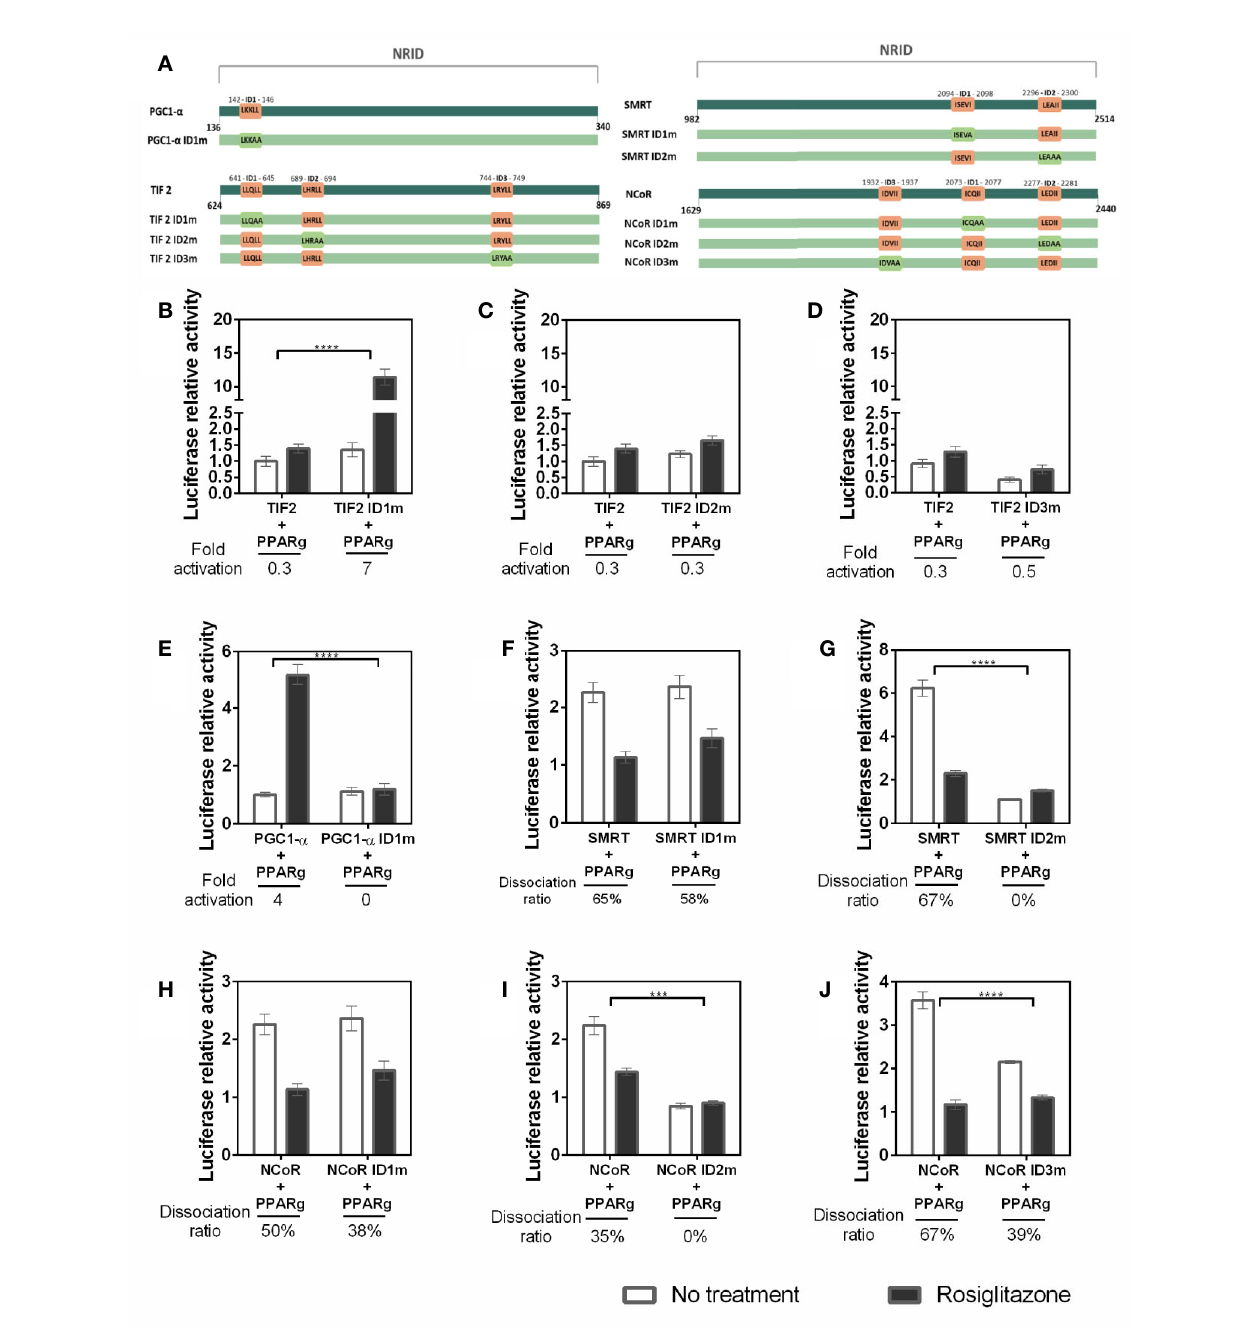
FIGURE 6 | Af fi nity of the coregulators IDs with PPAR g . (A) Representative image of the IDs in the sequences used and their respective mutations. In dark green are the original sequences, in light green are the mutated sequence. The original IDs sequence are in orange squares and the mutations on IDs are presented on light green squares. (B – J) Mammalian two hybrid assays were performed to evaluate whether the mutation on each interaction domain (ID) of the coregulators alters the interaction with PPAR g . (B) Comparison between interaction with TIF2 coactivator wt and PPAR g , and the ID1 of TIF2 mutated (TIF2 ID1m) and PPAR g . (C) ID2 of TIF2 coactivator mutated. (D) ID3 of TIF2 coactivator mutated. (E) ID1 of PGC1- a coactivator mutated. (F) ID1 of SMRT corepressor mutated. (G) ID2 of SMRT corepressor mutated. (H) ID1 of NCoR corepressor mutated. (I) ID2 of the NCoR corepressor mutated. (J) ID3 of the NCoR corepressor mutated. Error bars, SEM. (n = 15) Statistical analysis: two-way ANOVA. p-value: P values: p ≤ 0.001***; p ≤ 0.0001****. For the TIF coactivator the withdrawal of ID1 improves the interaction, in this case we can say that ID1 interferes with the interaction PPAR g -TIF2 and ID3 of the same coactivator is the most important for the interaction. In the case of PGC1- a , we only have 1 ID and when it is not present the interaction is broken. For SMRT and NCoR, ID 2 is important, ID1 does not change the interaction and ID3 of NCoR seems to contribute to the interaction with PPAR g